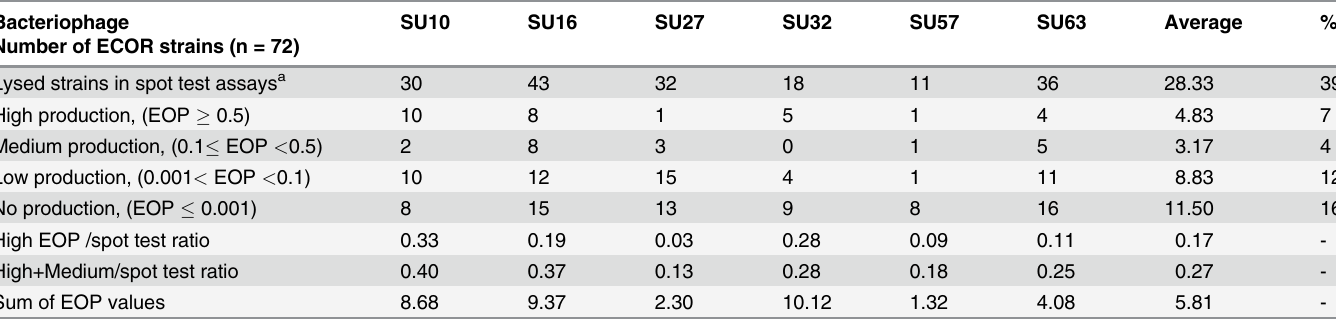
Table 2. Results of spot test assays and ef fi ciency of plating (EOP) on strains of the ECOR collection. Bacteriophage SU10 % Number of ECOR strains (n = 72) Lysed strains in spot test assays a High production, (EOP (cid:1) 0.5) Medium production, (0.1 (cid:3) EOP < 0.5) Low production, (0.001 < EOP < 0.1) No production, (EOP (cid:3) 0.001) High EOP /spot test ratio High+Medium/spot test ratio Sum of EOP